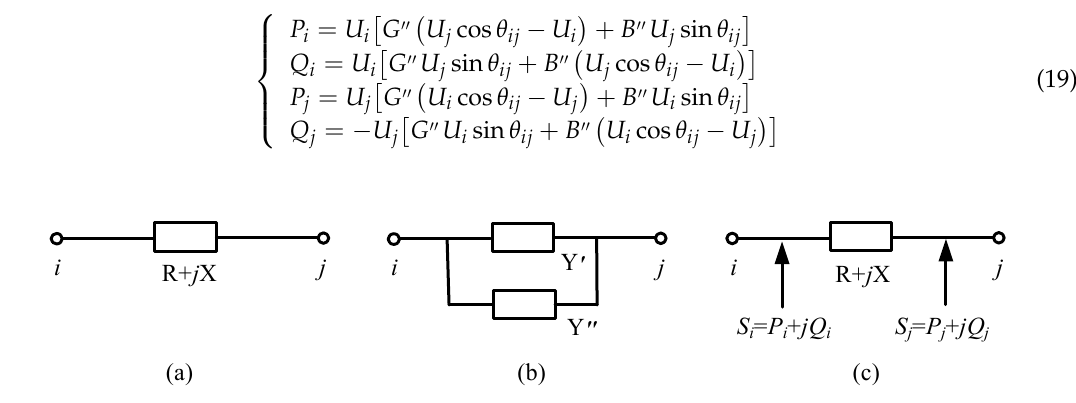
Figure 7. The models of the traction network. ( a ) The impedance model of the traction network; ( b ) the parallel equivalent impedance model of the traction network; ( c ) the simplified equivalent impedance model of the traction network.